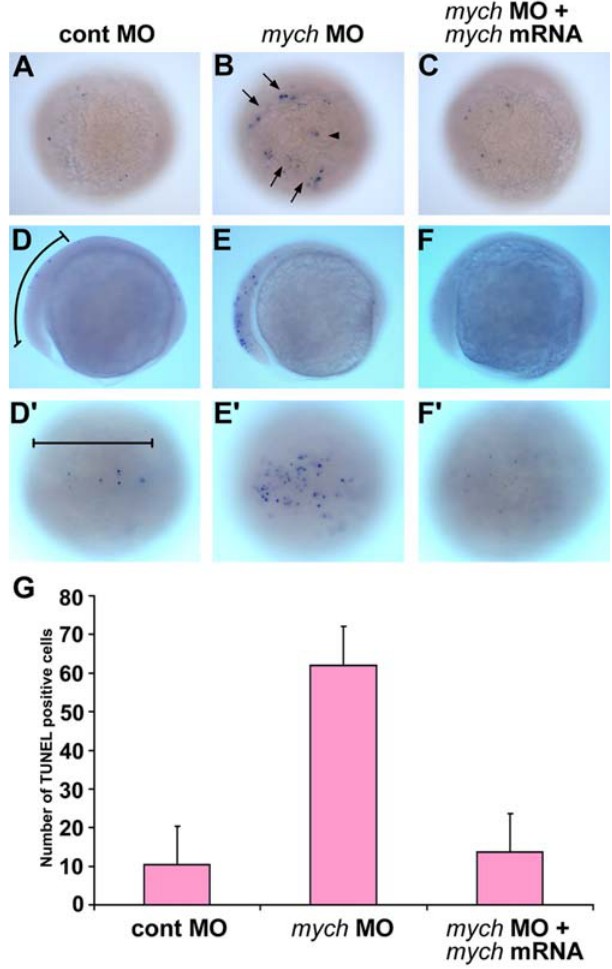
Figure 8. Mych depletion results in apoptosis in the early neural plate. A–F’. Detection of cell death by TUNEL assay. Lateral views (D,E,F) and dorsal views (A,B,C,D’,E’,F’) of control MO (A,D,D’), mych UTR MO (B,E,E’), and rescued embryos that received mych UTR MO and mRNA (C,F,F’) at the bud (A–C) and 3-somite stage (D–F’). Arrows in B point out TUNEL positive cells at the lateral edge of the neural plate. An arrowhead in B indicates TUNEL positive cells in the neural plate. Bracket in D and D’ indicates the anterior neural plate region in which TUNEL-positive cells were counted. The results are shown in G. Average numbers of positive cells per embryo were obtained by counting 20 embryos in each group. For both comparisons p , 0.01: Cont MO vs. mych MO: p=5.27e-14; mych MO vs. rescue: